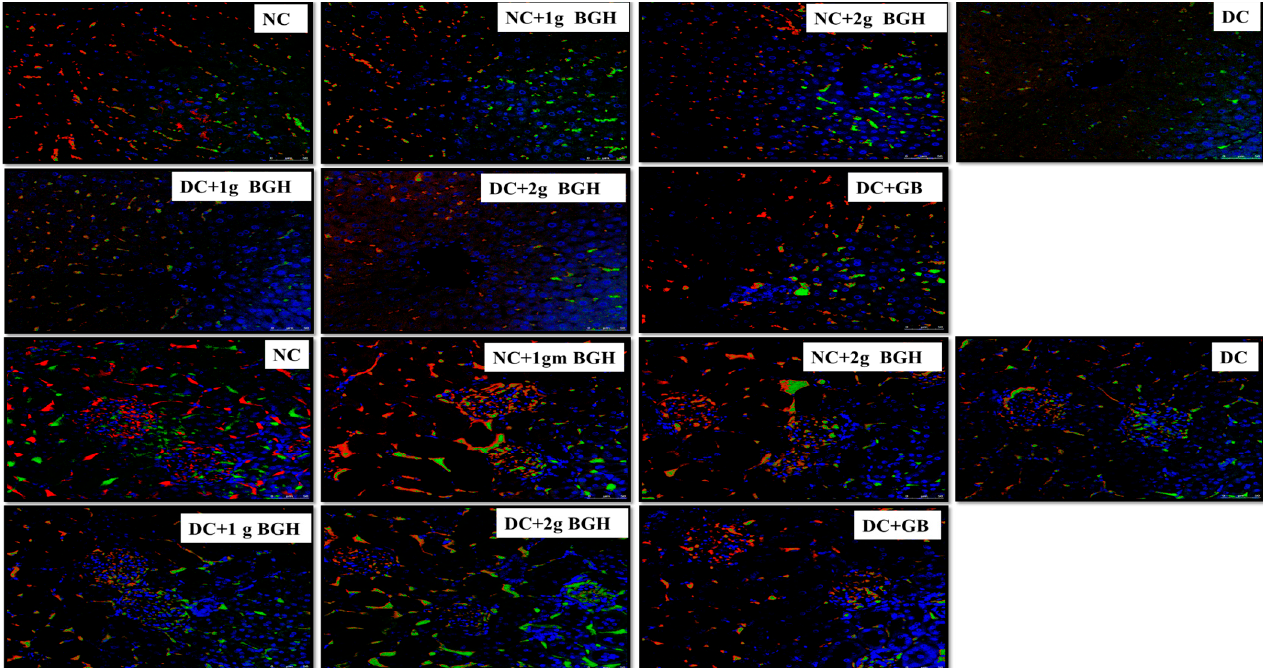
Figure 5. Representative confocal images of antioxidant markers Nrf2 (red) and NOQ1 (green) double immunofluorescence staining in the liver ( A ) and kidney ( B ) samples from BGH-treated rats. Quantitative analyses of immunofluorescence signals in the liver ( C ) and kidney tissues ( D ). The results were collected from six separate rats within every treatment group and were reported as a mean ± S.E.M. *** p < 0.001 vs. NC; # p < 0.05; ## p < 0.01 vs. DC. S Scale bar = 100 µ m. NC: Normal control; NC+1g BGH: Non-diabetic rats that received 1 g/kg/day BGH; NC+2g BGH: Non-diabetic rats that received 2 g/kg/day BGH; DC: Diabetic control; DC+1g BGH: Diabetic rats that received 1 g/kg/day BGH; DC + 2g BGH: Diabetic rats that received 2 g/kg/day BGH; DC+GB: Diabetic rats that received 2 mg/kg/day glibenclamide.